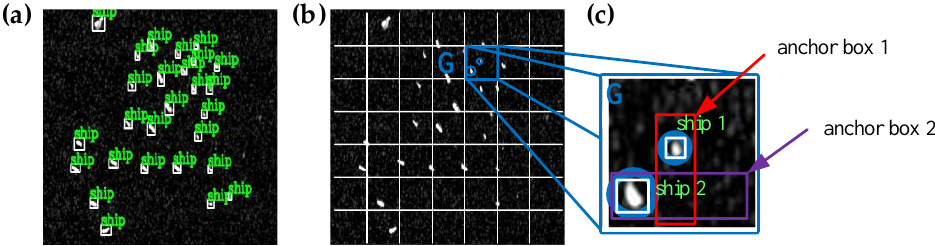
Figure 9. Anchor box. ( a ) Ground truth; ( b ) image mesh; ( c ) the grid cell responsible for predicting ships.